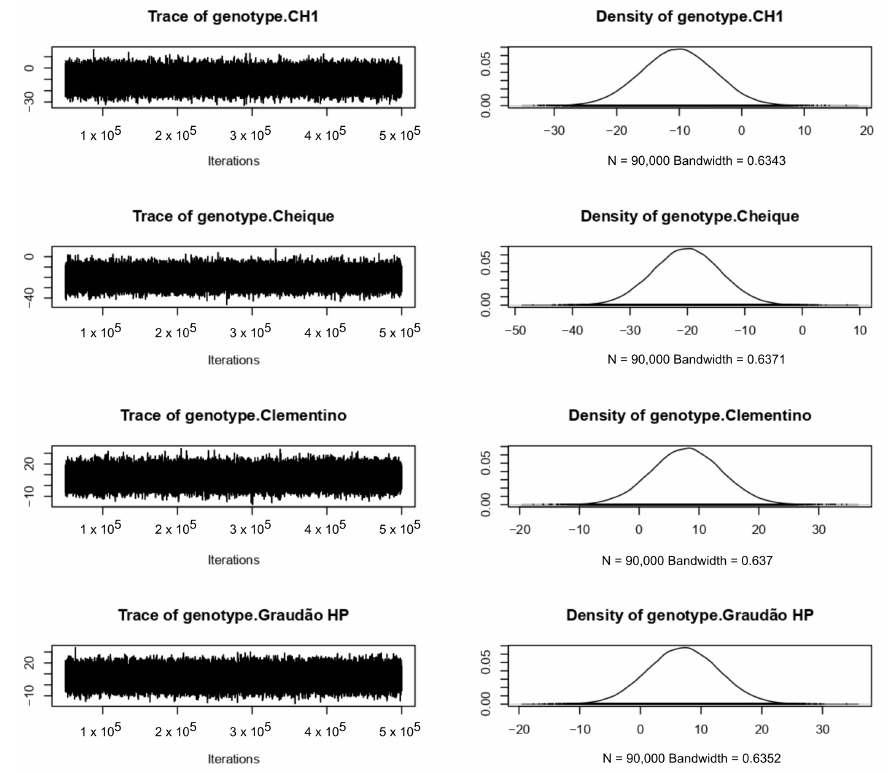
Figure A4. Time series of the chains and density curves of the effect of genotypes CH1, Cheique, Clementino, and Graudão HP.